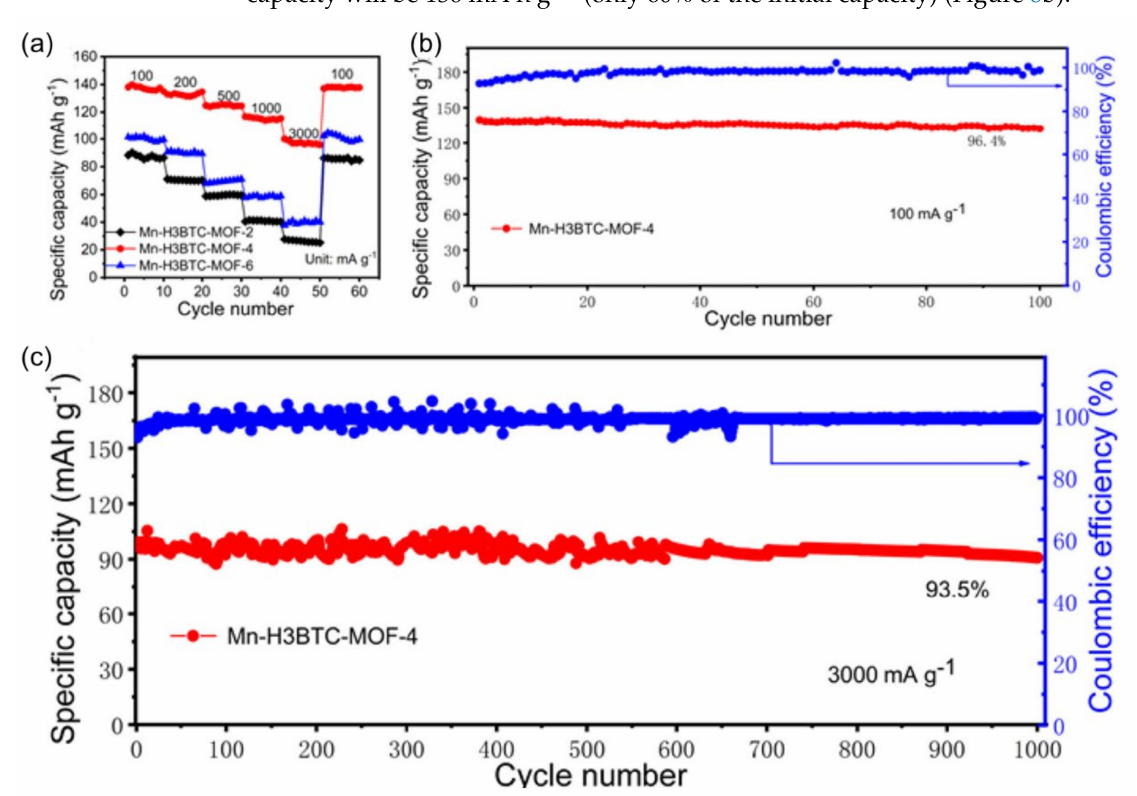
Figure 7. ( a ) The rate capability (from 100 to 3000 mA g − 1 ) and ( b , c ) cycling performance of Mn- H 3 BTC-MOF-4 at 100 and at 3000 mA g − 1 , respectively. Reprinted with permission from Ref. [68]. Copyright 2021 American Chemical Society.